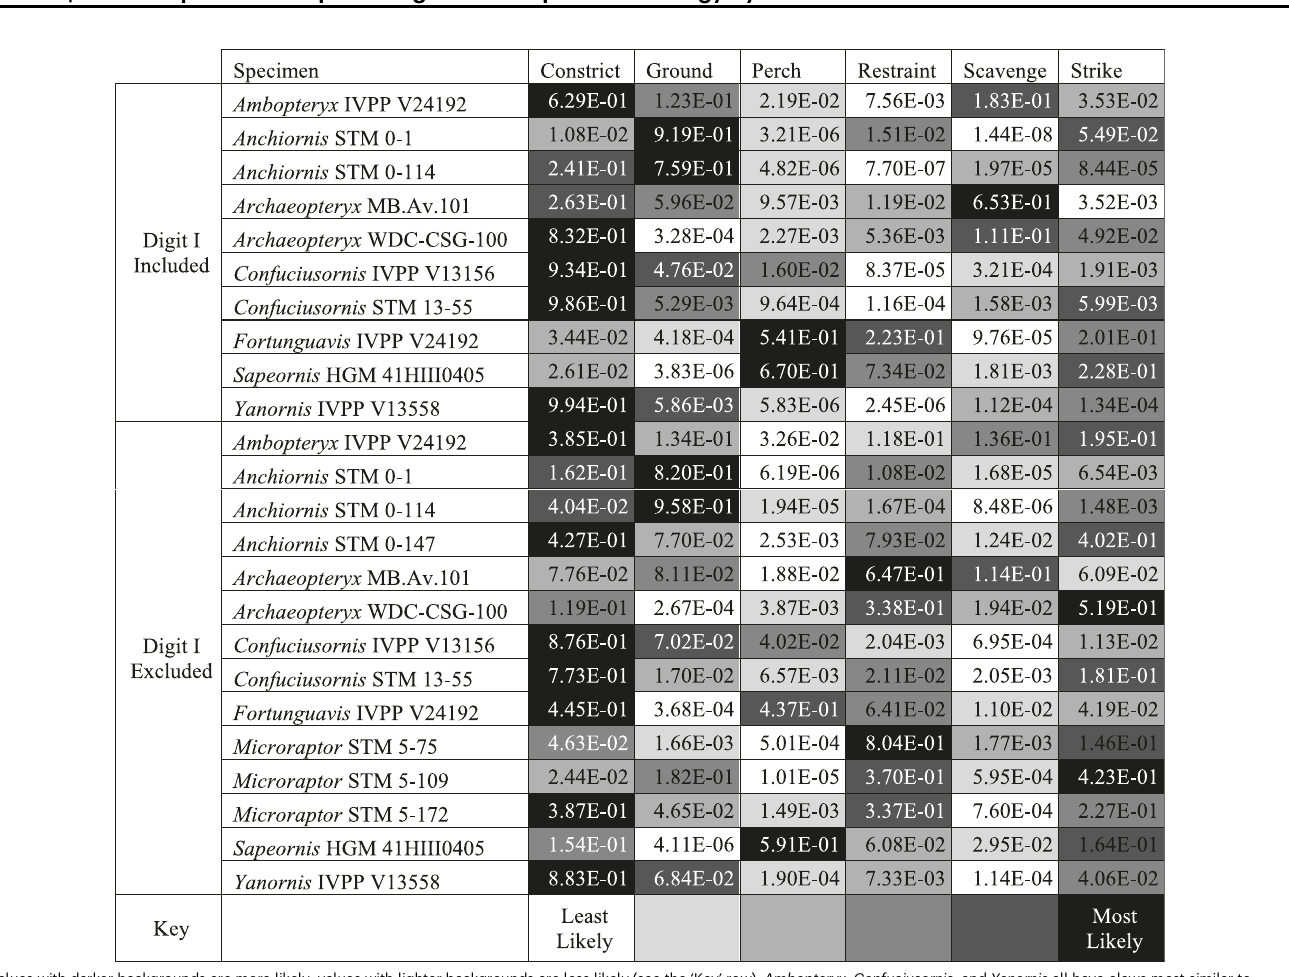
Table 2 | p values from phylogenetic honest signi fi cant differences (HSD) test, testing whether modern bird claws with different ecological groupings have different shapes, via traditional morphometrics when digit I is excluded Constrict Ground Perch Restraint Scavenge Strike Constrict